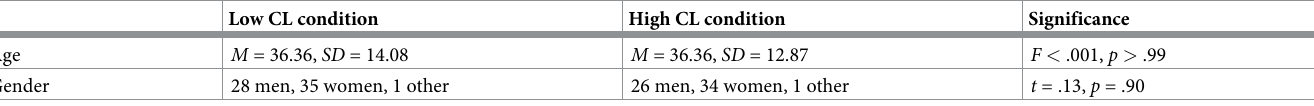
Table 3. Descriptive statistics by experimental condition in Study